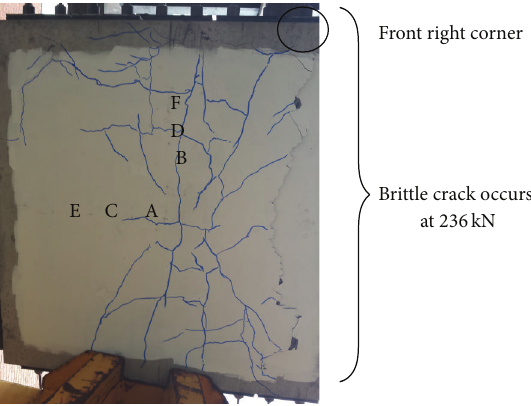
Figure 46: Transducer displacements (P.L., B, D, F).